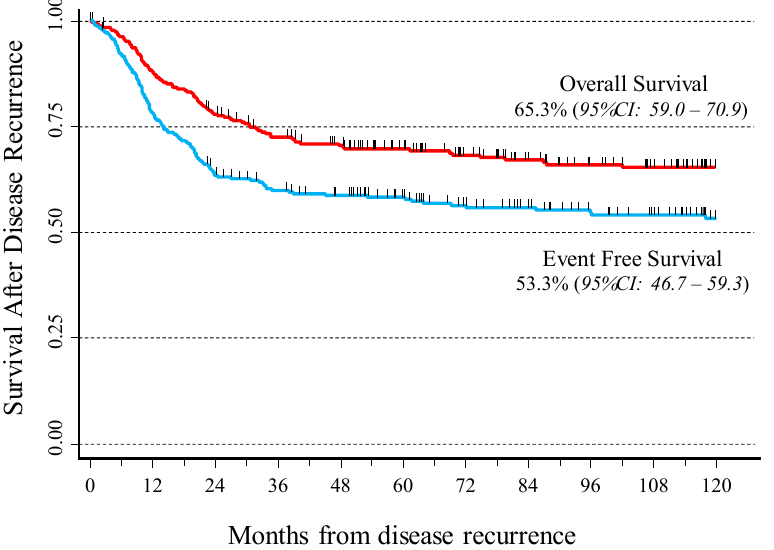
Figure 2. Overall and event-free survival after disease recurrence in 272 cHL patients.